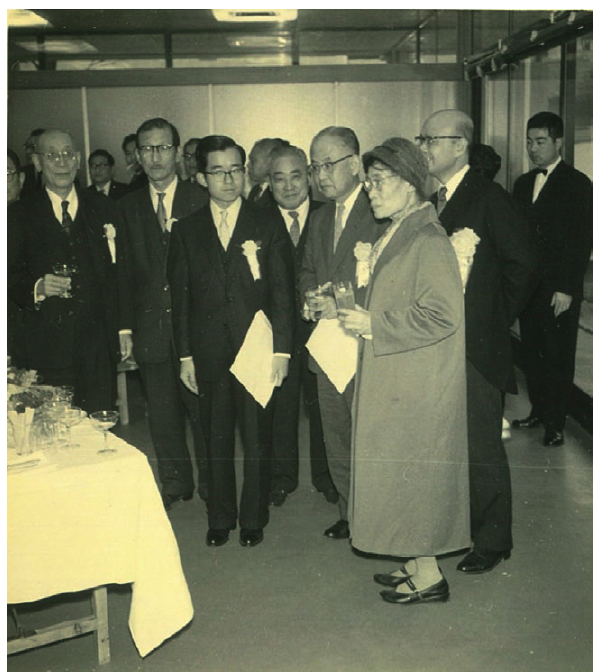
Figure 10. (Ku-2012), 1961, 1163. Yoshinomiya and the author [Kuroda Chika] at the completion celebration venue of the Chemi- cal Society of Japan Chemistry Library (Courtesy of Ochanomizu University History Museum).